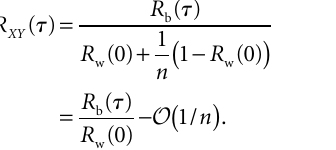
Figure 2 | The effect of pooling in feedforward networks. (A) A schematic diagram of a feedforward network with random connectivity. Each layer consists of N cells. Each cell in layer k + 1 receives a fixed number of randomly selected inputs from layer k . (B) The stages of processing in the network pictured in (A) . Outputs from layer k are pooled to form the input to each cell in layer k + 1. These inputs are, in turn, decorrelated by the cells in layer k + 1. The combined effect can lead to large gains in